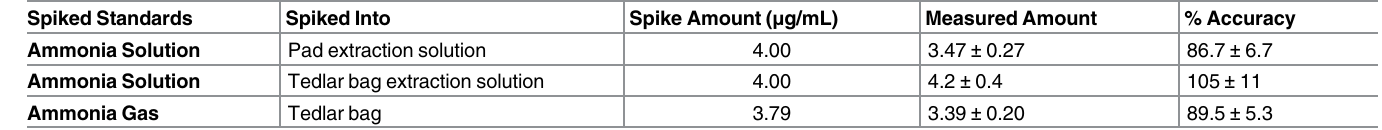
Table 1. Evaluation of Extraction Recovery using spiked standards for the ammonia in mainstream smoke method.